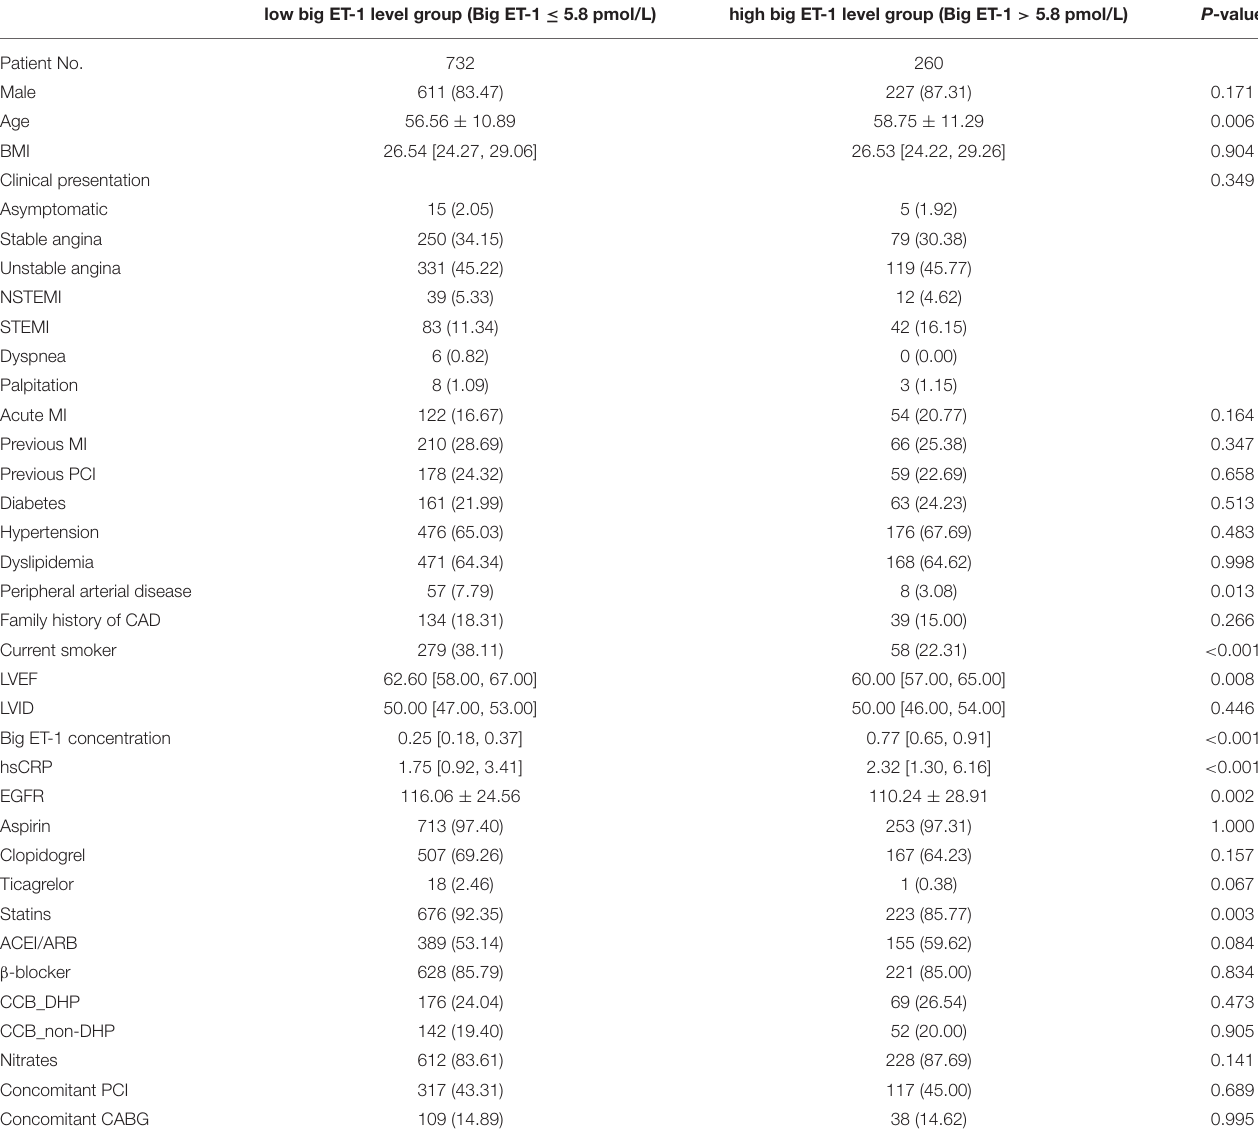
TABLE 1 | Baseline characteristics of the study